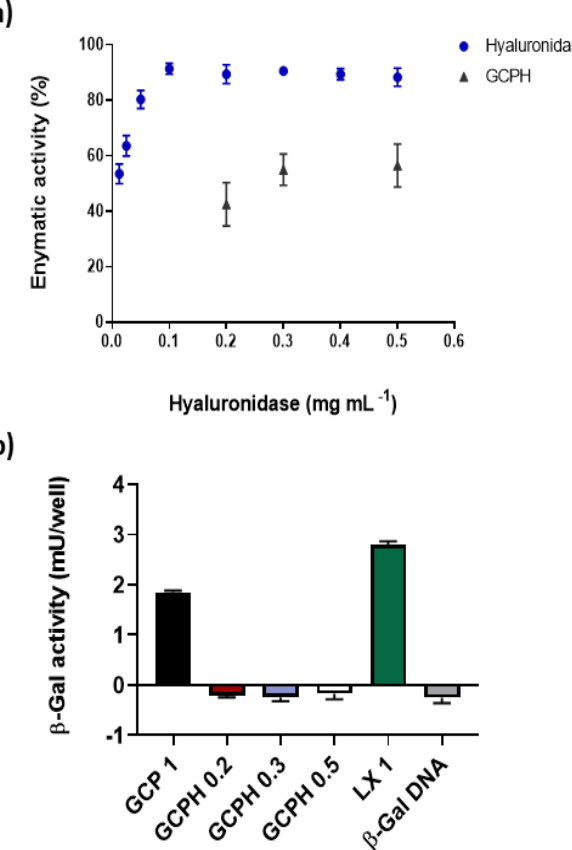
Figure 3. Hyaluronic acid digestion potential of the ternary complexes and free enzyme ( a ). Trans- fection efficiency of GCP 1 (black bar), GCPH 0.2 (brown bar), GCPH 0.3 (blue bar), GCPH 0.5 (white bar), LX (green bar) and naked β-Gal DNA (grey bar) ( b ). The data is representative of three independent experiments ( n = 3, mean ± SD).